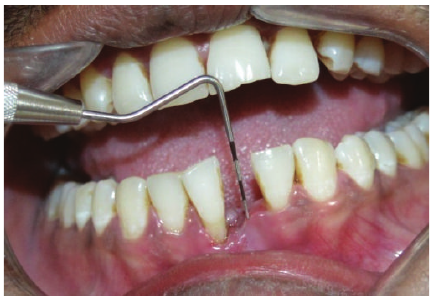
Figure 4: Space measurement for pontic.